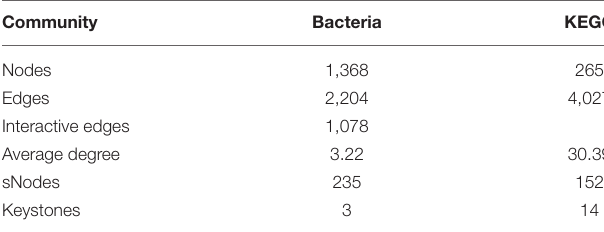
TABLE 4 | Topological properties of the co-occurrence network.